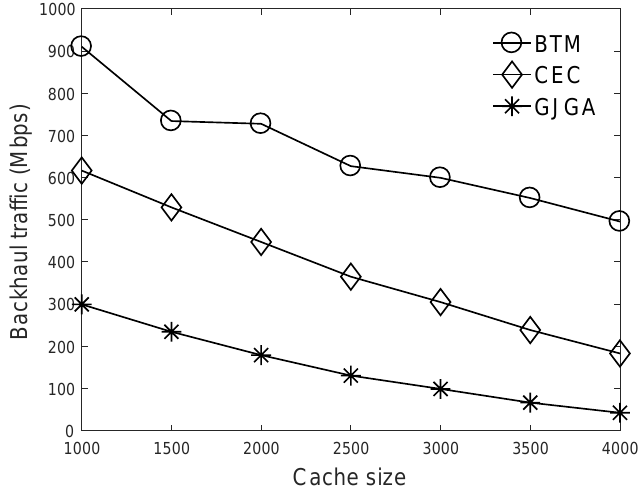
Figure 5. Effects of the cache size on the total backhaul traffic under 600 UEs and 8000 video files.